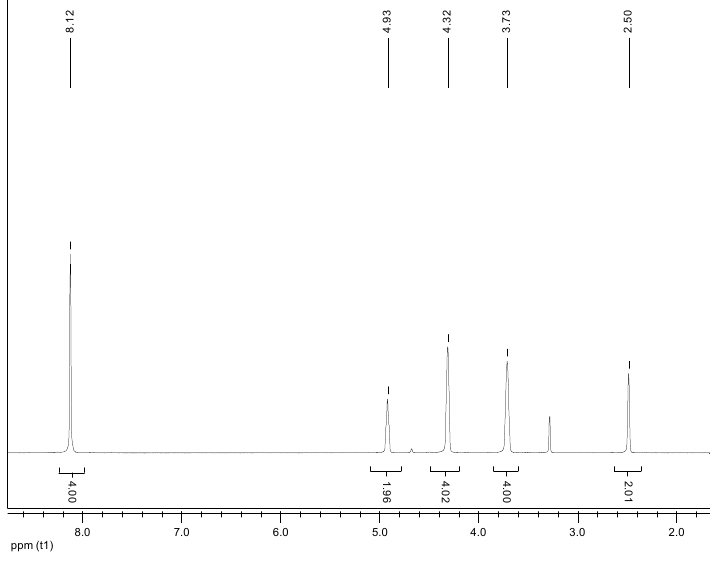
Figure 3. 1 H-NMR spectrum of main glycolysis